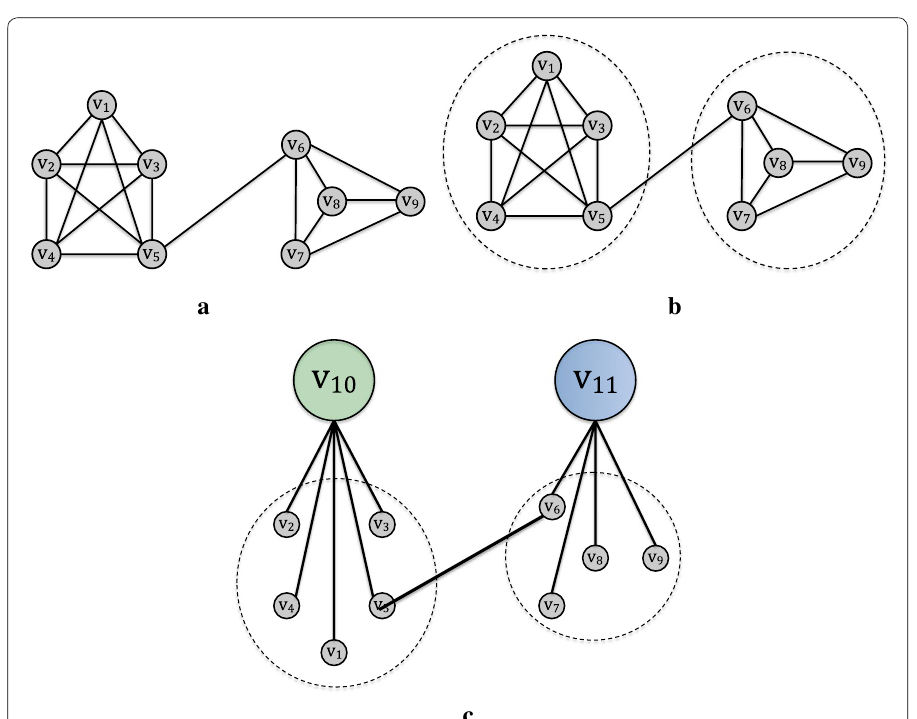
Fig. 4 Overview and intuition for the proposed graph compression techniques. a Simple graph. b Cliques identified. c Encoding